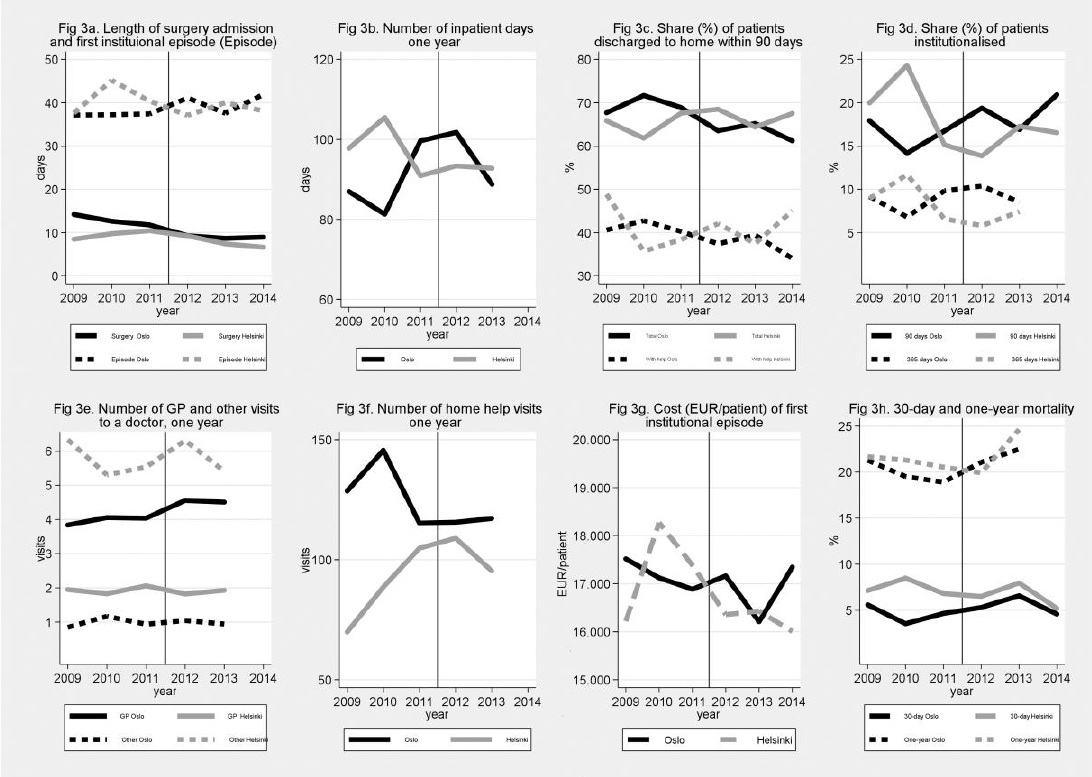
Figure 3: Trends in performance measures in Oslo and Helsinki: age, gender, and type of fracture, standardised